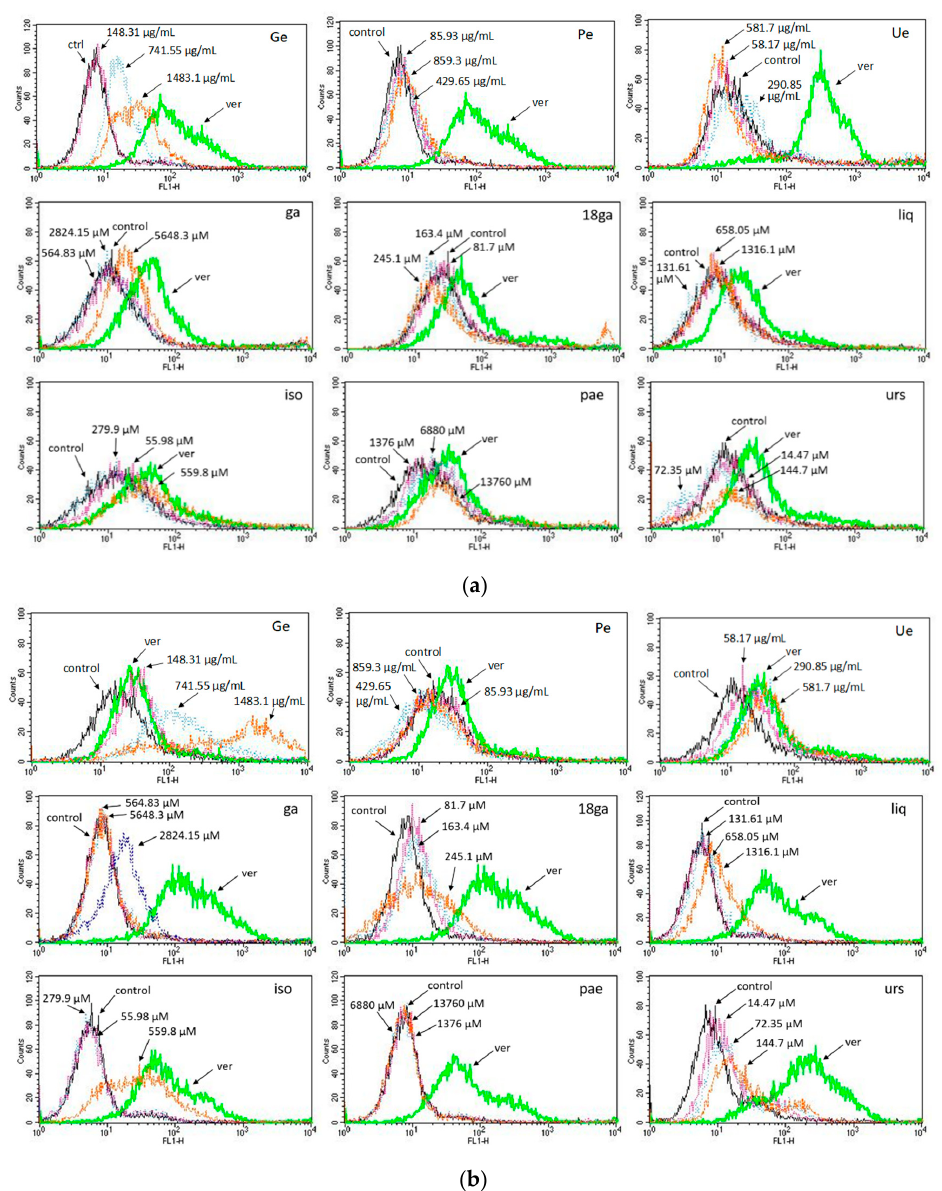
Figure 2. Histograms of flow cytometry of calcein-AM ( a ) and rhodamine 123 ( b ) retention in CEM/ADR 5000 cells after 1.5 h treatment with three concentrations (IC 50 , IC 50 × 5, and IC 50 × 10) of a single substance compared to the treatment with 50 µM verapamil (positive control). All experiments were repeated at least three times.